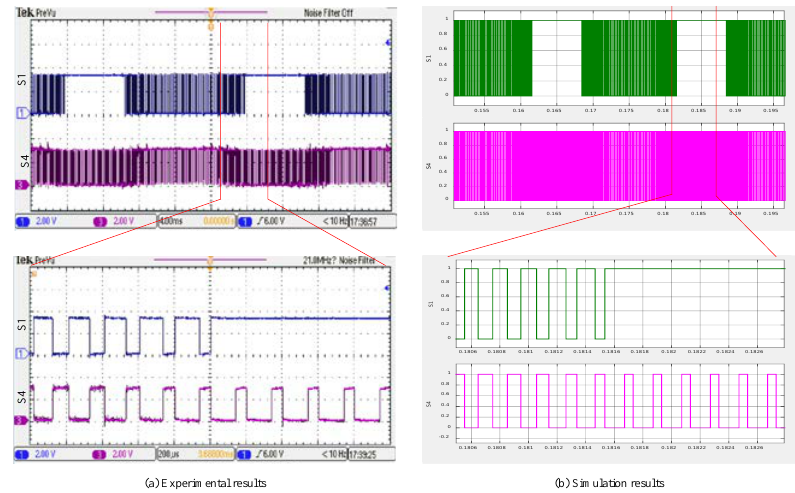
Figure 27. Gating pulses of upper and lower switch of the first inverter leg.